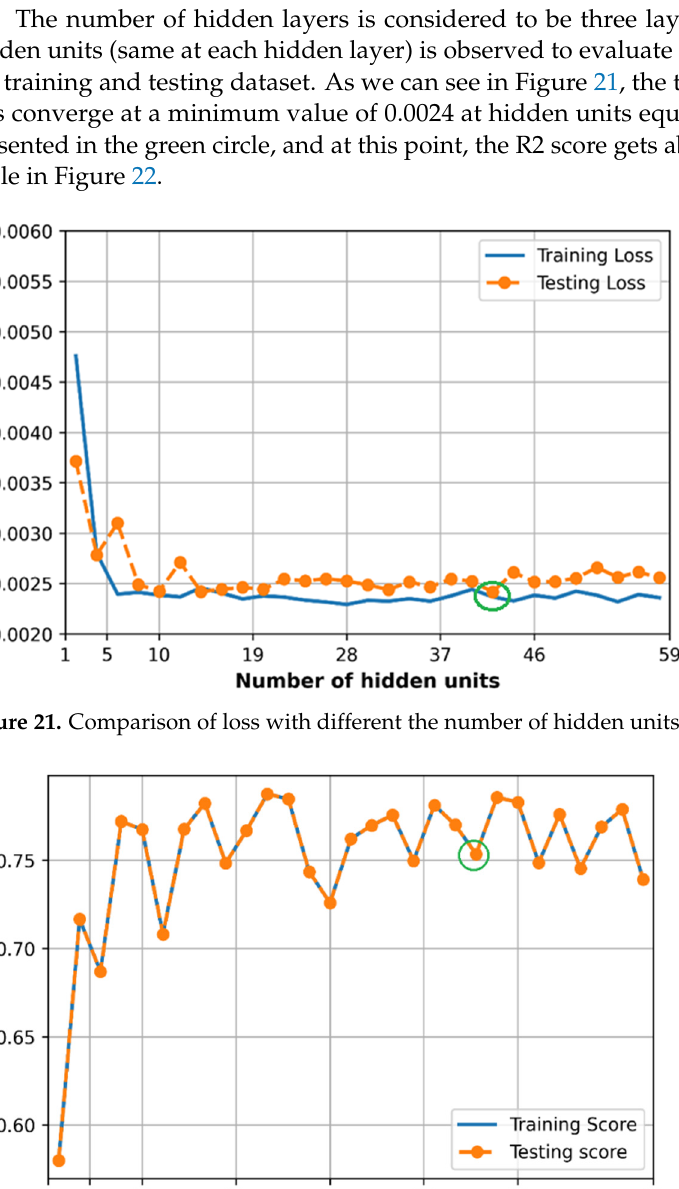
Figure 20. Comparison of accuracy with different regularization factor.